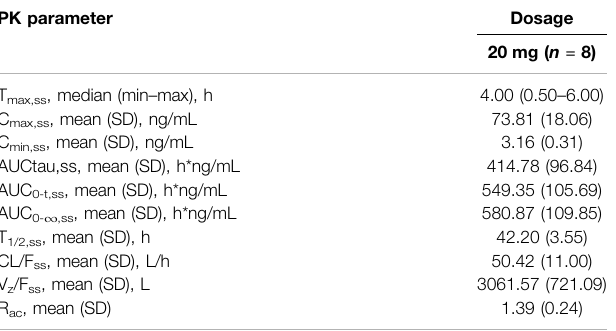
TABLE 4 | Pharmacokinetic (PK) properties of TQ-F3083 after administration of multiple 20-mg doses. PK parameter Dosage